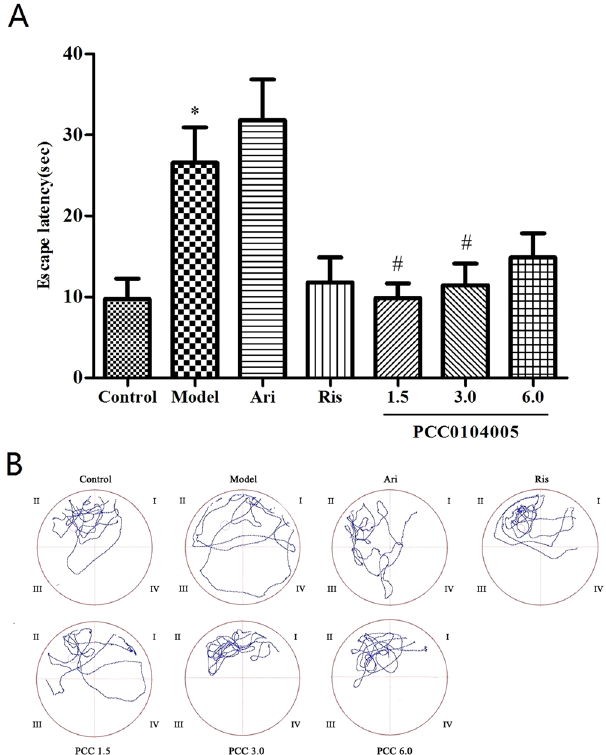
Figure 5. Effects of subchronic (sc) administration of PCC0104005 on MK-801-treated rats in the MWM test. Rats were administered an oral dose of vehicle alone or PCC0104005 (1.5, 3.0, or 6.0 mg/kg), aripiprazole (Ari, 1.5 mg/kg) or risperidone (Ris, 0.2 mg/kg) for 28 days. Beginning on the 15th day, intraperitoneal injections of 0.9% saline or MK-801 (0.3 mg/kg) were administered to 28th day. ( A ) Effects of different drugs on escape latency in rats. Results are presented as mean ± S.E.M. (n = 8). * P < 0.05, ** P < 0.01 model group vs. the control group, # P < 0.05, ## P < 0.01 drug delivery groups vs. the model group. ( B ) Representative track activity of rats in the target quadrant on the 6th